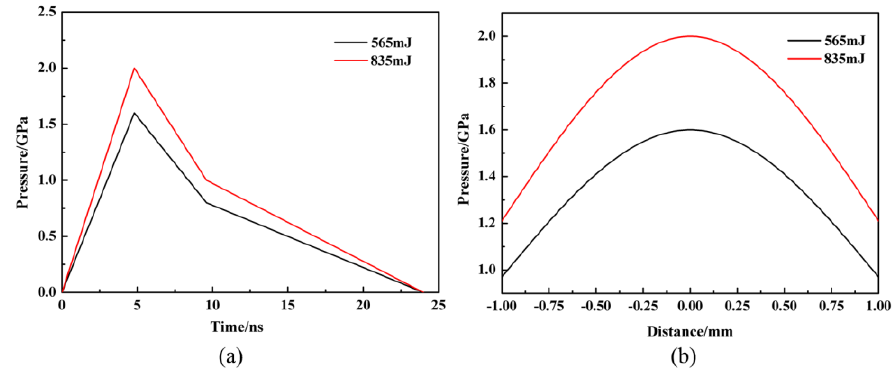
Figure 3. ( a ) The temporal distribution of the shock wave pressure; ( b ) the spatial distribution of the shock wave pressure.